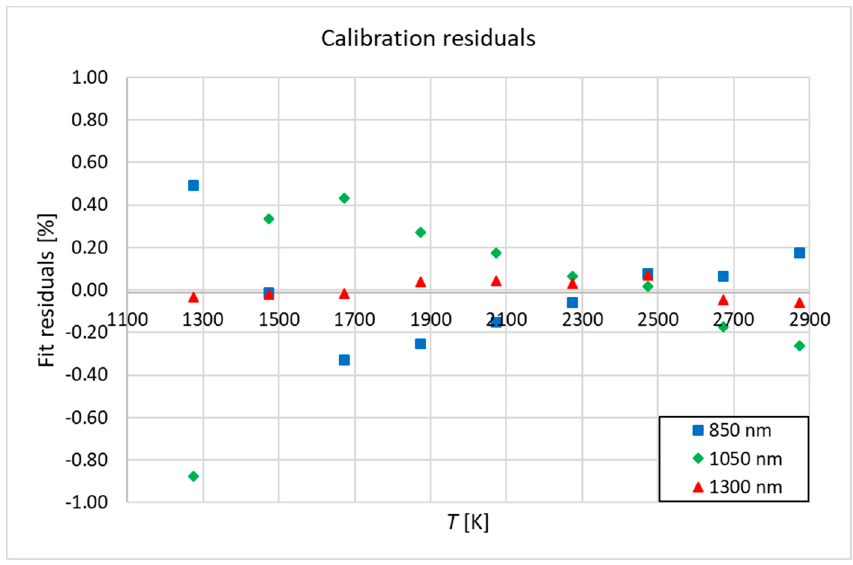
Figure 9. Calibration residuals.